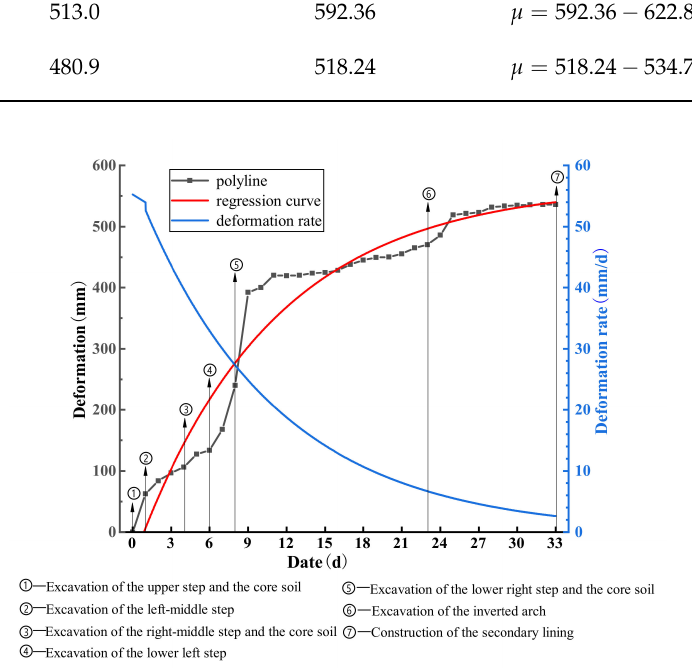
Figure 18. Deformation analysis diagram of the vault of the YK280+212 section of the